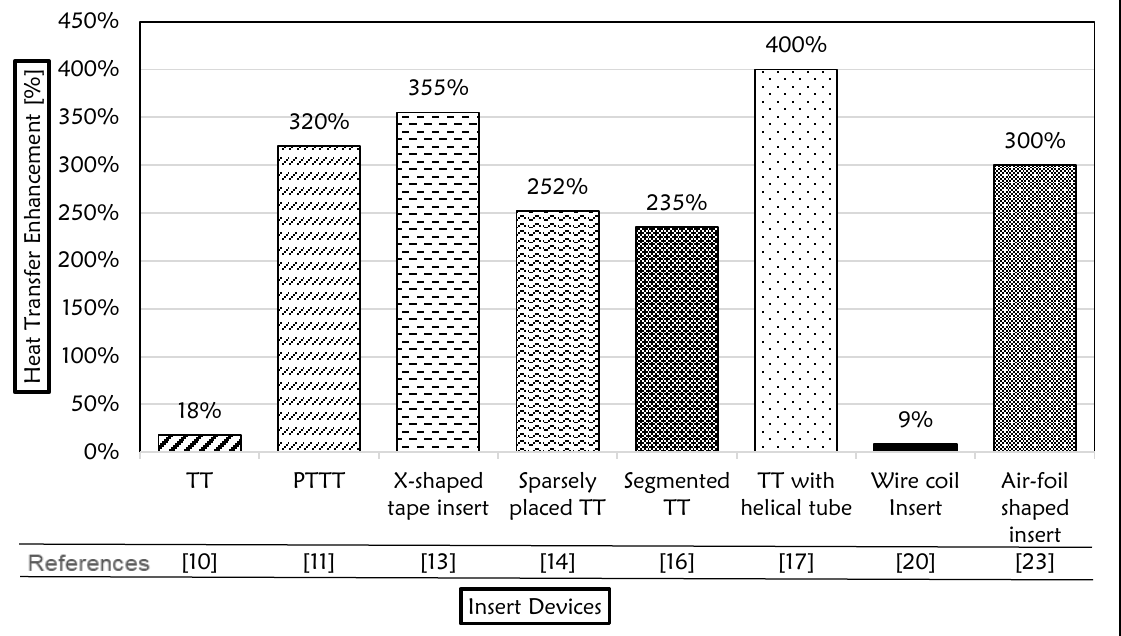
Figure 18: Equivalent percentage of heat transfer enhancement with different insert devices.